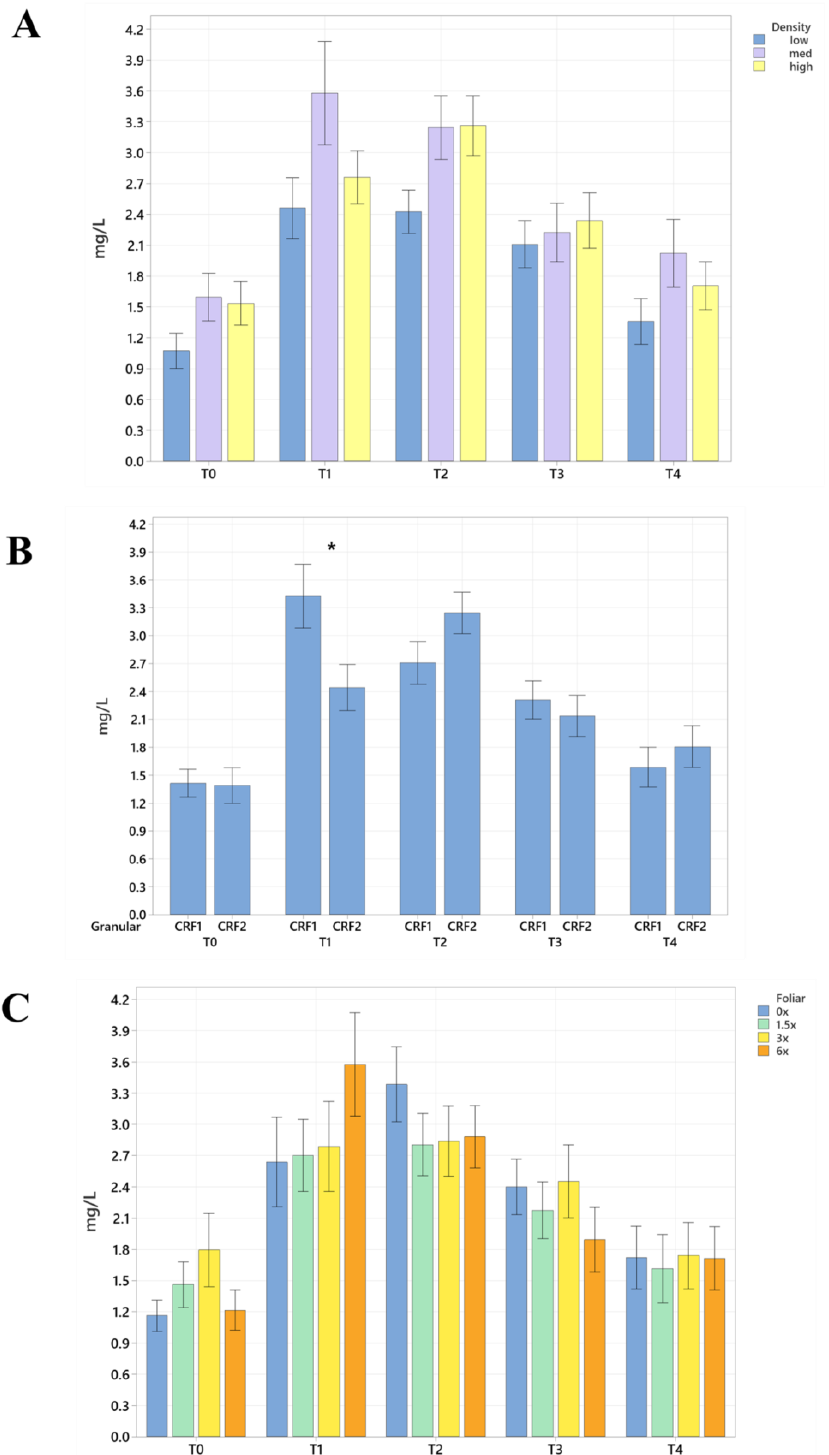
Figure 9. Root density of ‘Ray Ruby’ grapefruit grafted on ‘Kuharske’ citrange planted in flatwood soils located in Fort Pierce, FL, USA, in response to ( A ) planting density, ( B ) ground-applied fertilizer and ( C ) foliar fertilizer treatments during September 2020 (T0), January 2021 (T1), May 2021 (T2), September 2021 (T3) and January 2022 (T4). Bars are ± standard deviation of the mean, and treatments with * were considered to be significantly different ( p < 0.05).